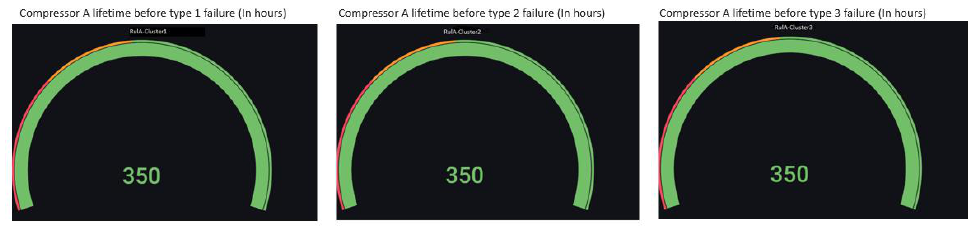
Figure 19. Fault-type gauge .